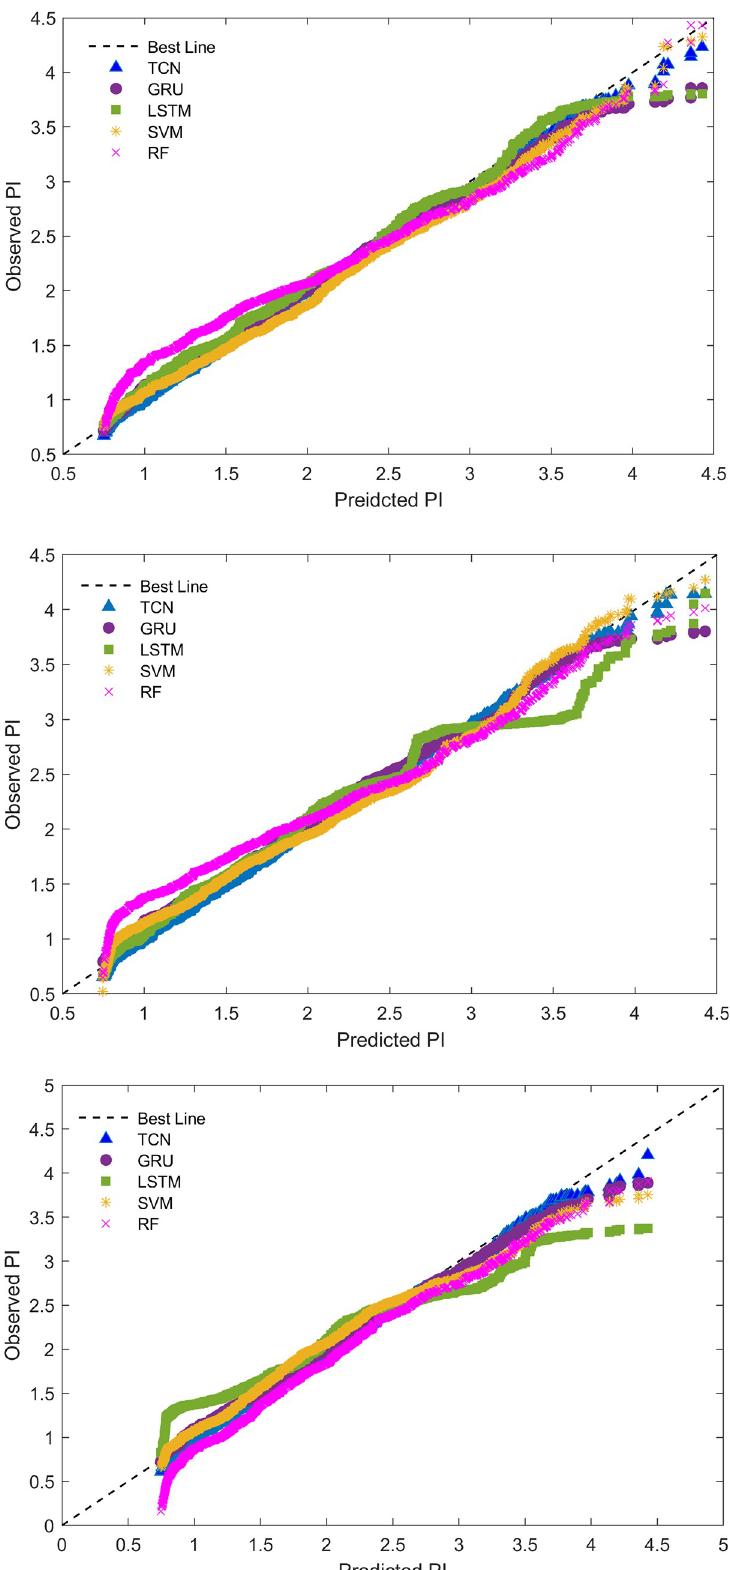
Fig 8. Agreement between the observed and predicted PI values for the model considered in this study. ( a) Future 12-hour prediction. (b) Future 24-hour prediction. (c) Future 48-hour prediction. https://doi.org/10.1371/journal.pone.0254179.g008 PLOS ONE | https://doi.org/10.1371/journal.pone.0254179 July 23,